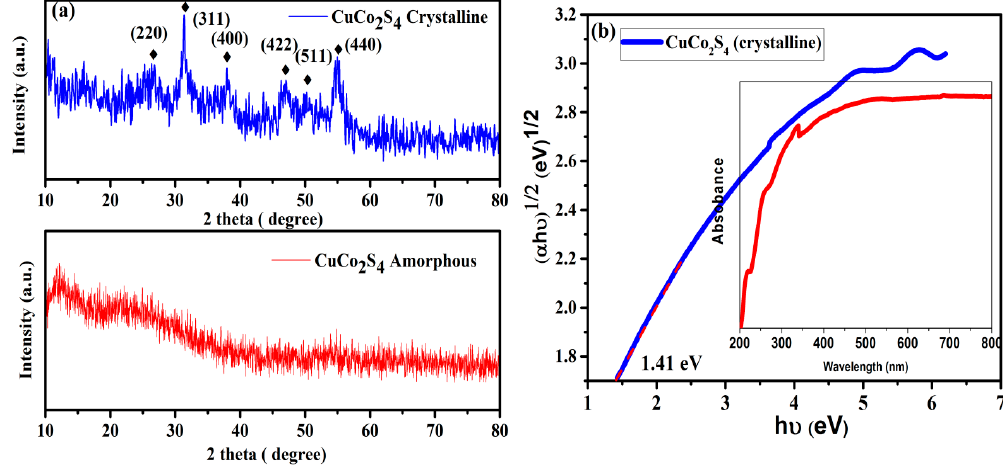
Figure 1. X-ray diffraction (XRD) patterns of ( a ) crystalline and amorphous CuCo 2 S 4 ( b ) UV–vis diffuse reflectance spectra and ( α h ν ) 2 versus h ν plots of crystalline CuCo 2 S 4 .